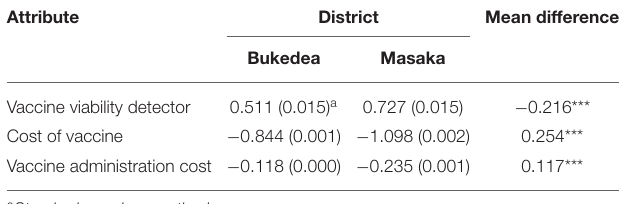
TABLE 5 | Mixed logit model estimates for T. solium cysticercosis vaccine attributes.